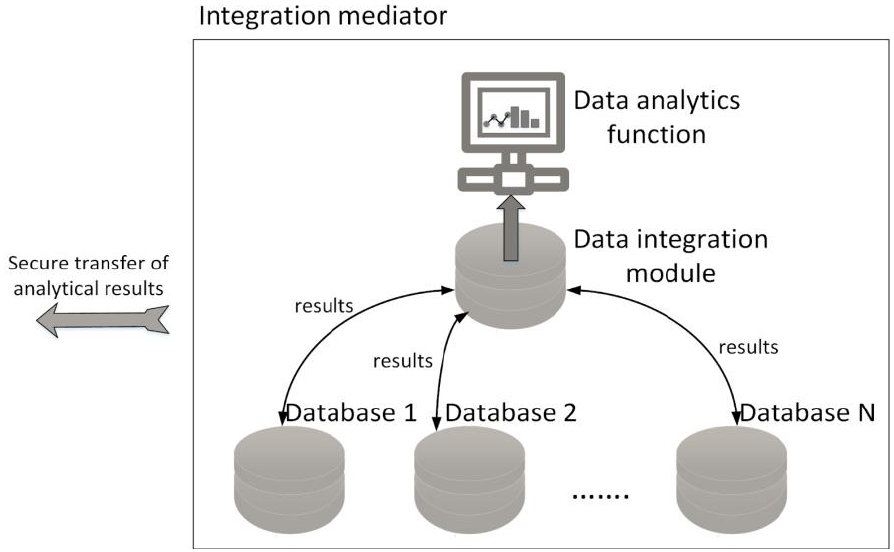
Figure 2. The logical architecture of the Integration mediator.